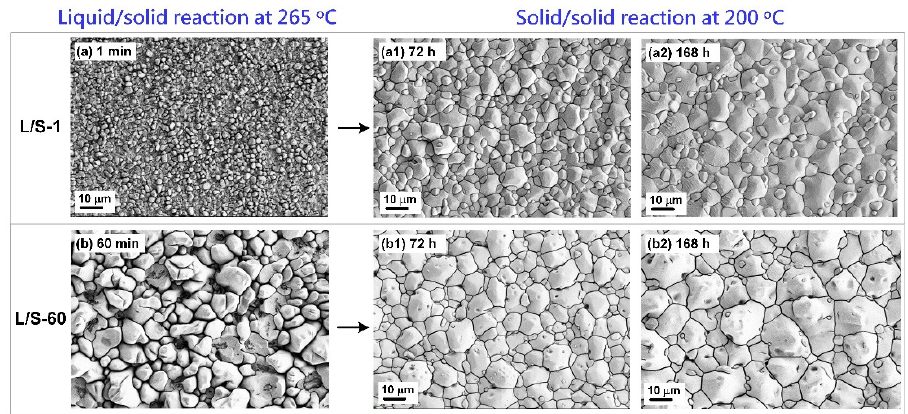
Figure 8. Top-view SEM micrographs of the Cu 6 Sn 5 grains in the L/S-1 ( a , a1 , a2 ) and L/S-60 ( b , b1 , b2 ) samples subjected to S/S reaction for various lengths of time.